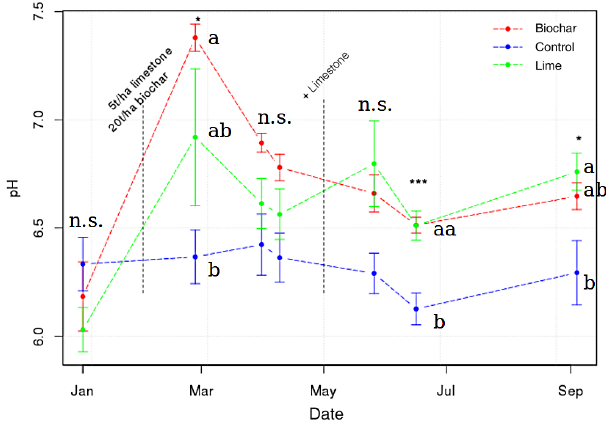
Figure 2. Soil pH (mean with 1 SE bars) during the time of the ex- periment. Significant differences ( p < 0.05) are indicated with stars according ANOVA test and Tukey Honest Significant Differences (TukeyHSD) are indicated by different letters, n.s. = not significant.